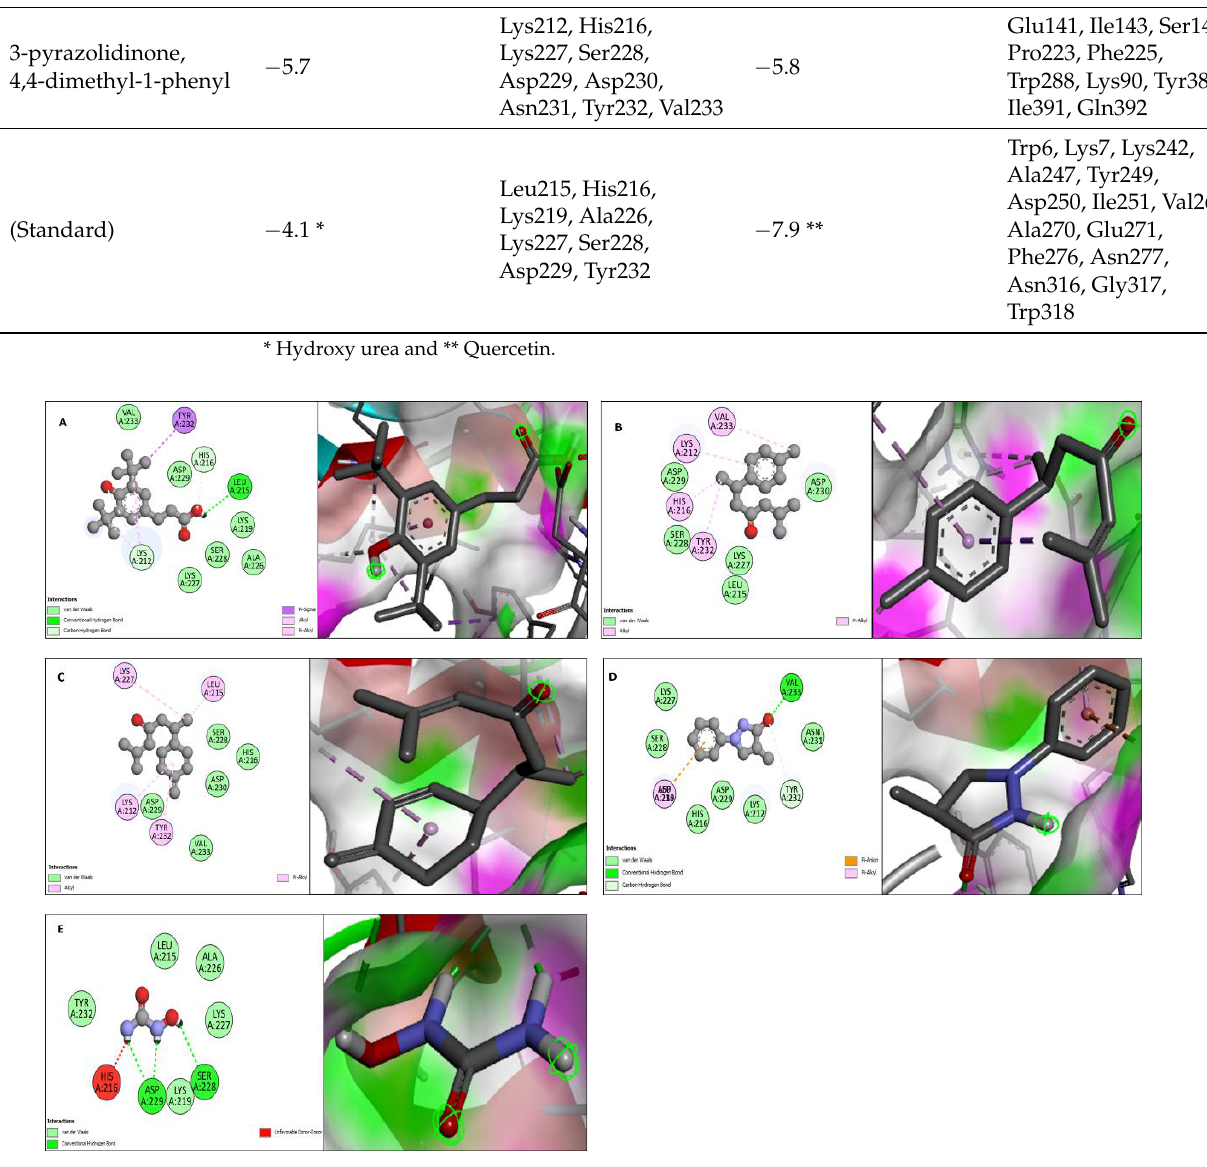
Figure 4. 2D and 3D interaction of urease with ligands. ( A ) Benzenepropanoic acid, 3,5-bis(1,1-di- methylethyl)-4-hydroxy-, methyl ester, ( B ) ar-Turmerone, ( C ) Curlone, ( D ) 3-pyrazolidinone, 4,4- dimethyl-1-phenyl and ( E ) Hydroxy urea.